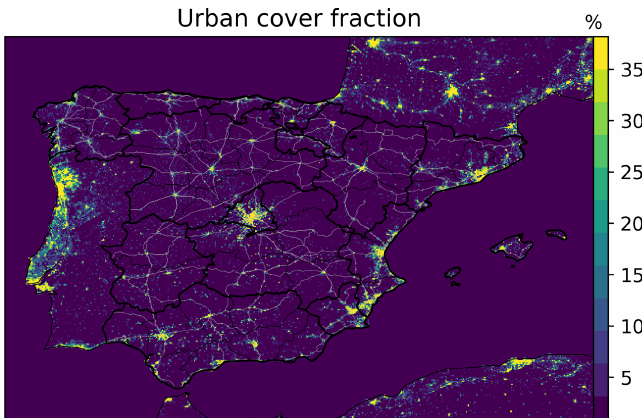
Figure G2. Urban land cover